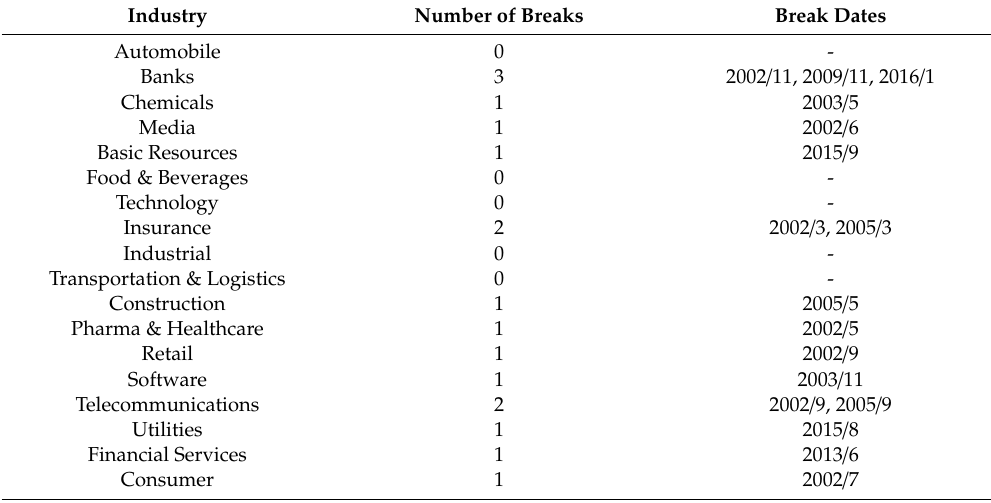
Table 5. Testing for structural change—the three factor models with HAC (Heteroskedasticity and Autocorrelation Consistent Covariances)